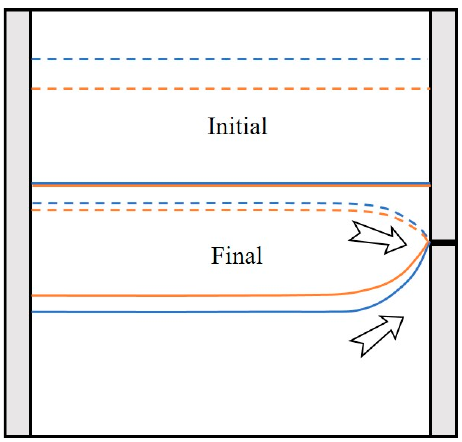
Figure 6. Schematic of initial and final interface states for two initial oil layers enclosed by blue and orange lines. Solid lines: l–l interface, Dashed lines: l–g interface.